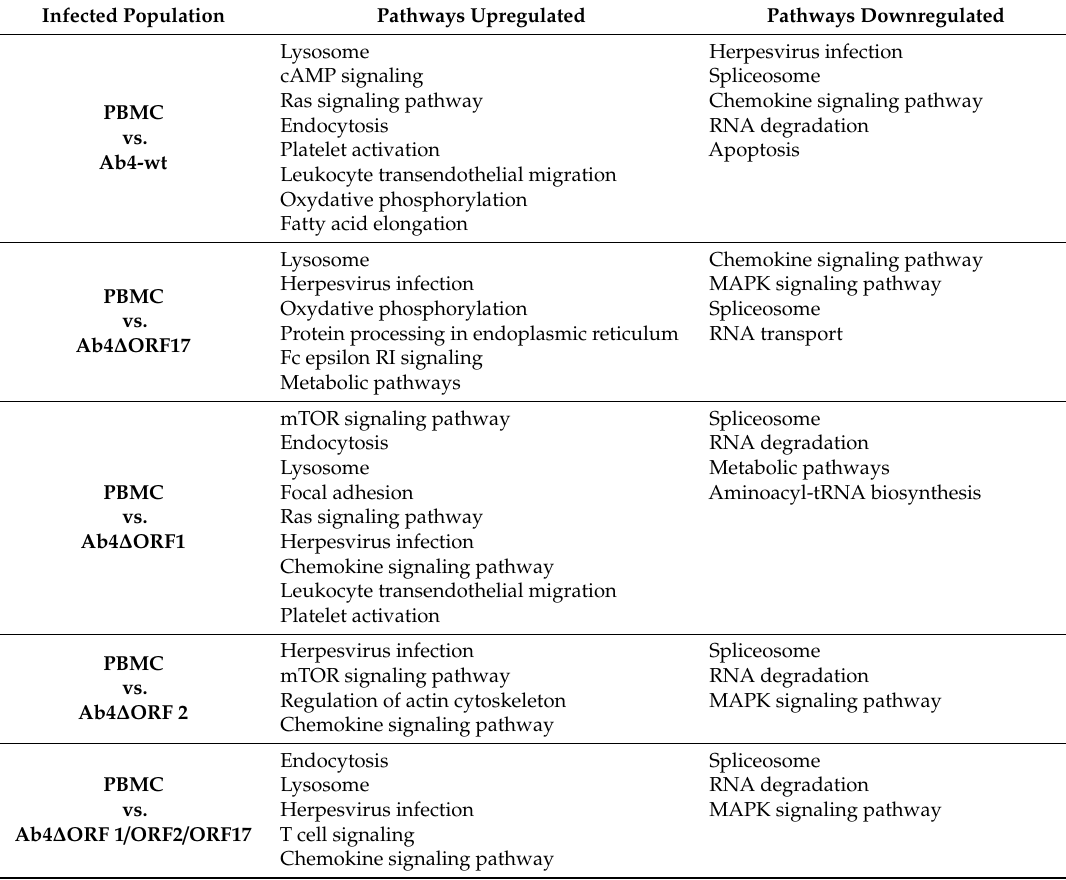
Table 4. Pathways di ff erentially regulated in Ab4-wt- and mutant viruses-infected PBMC. PBMC were infected with Ab4-wt or mutant viruses at an MOI of 1. At 24 hpi, infected PBMC were sorted and proteomic analysis was performed. Pathways significantly upregulated and downregulated (based on p -value and Benjamini-corrected Fisher’s exact test) in infected PBMC in comparison to non-infected PBMC are given; ( n =